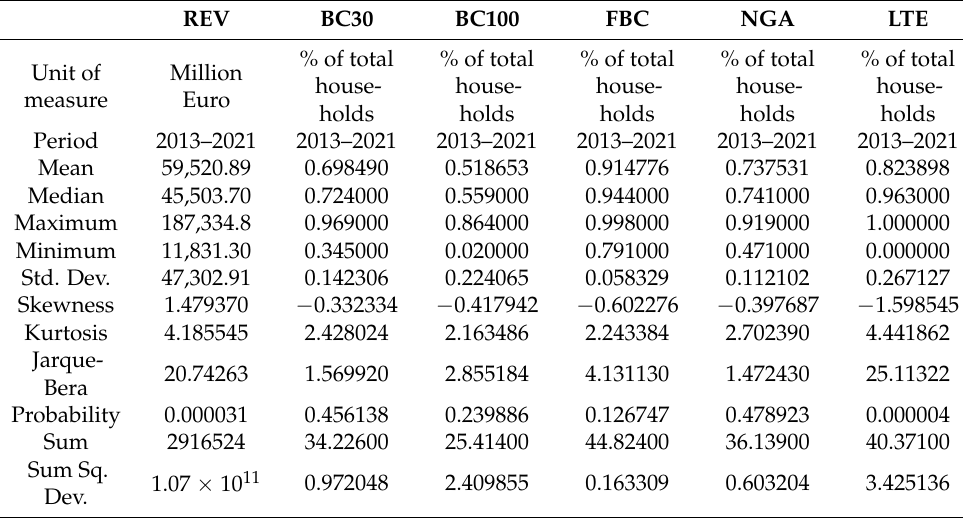
Table 1. Variables presentation and descriptive